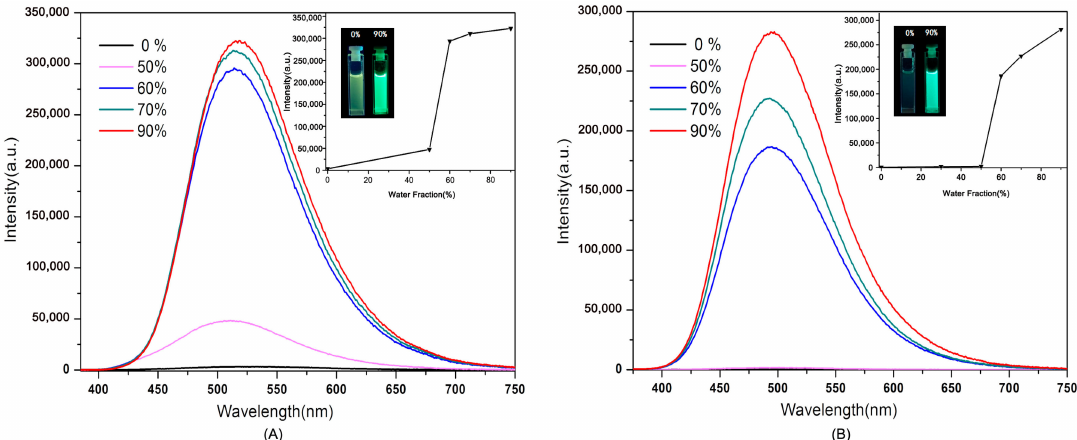
Figure 3. Fluorescence emission spectra of ( A ) L a ( λ ex = 365 nm); ( B ) L b ( λ ex = 343 nm) with inserts showing the plots of maximum emission intensity of ligands versus H 2 O fraction in H 2 O/DMSO mixtures and photographs of assemblies in pure DMSO and 90% H 2 O fractions mixture solution upon excitation at 365 nm using an UV lamp. c L = 50.00 µ M.